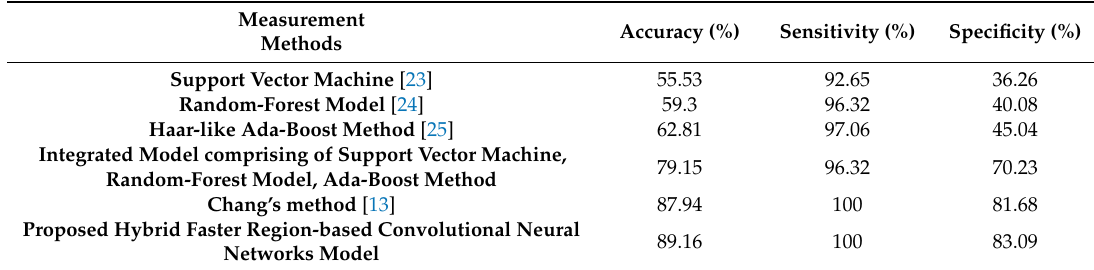
Table 5. Diagnosis of Bubble-defects in Treads of Tire Shearography